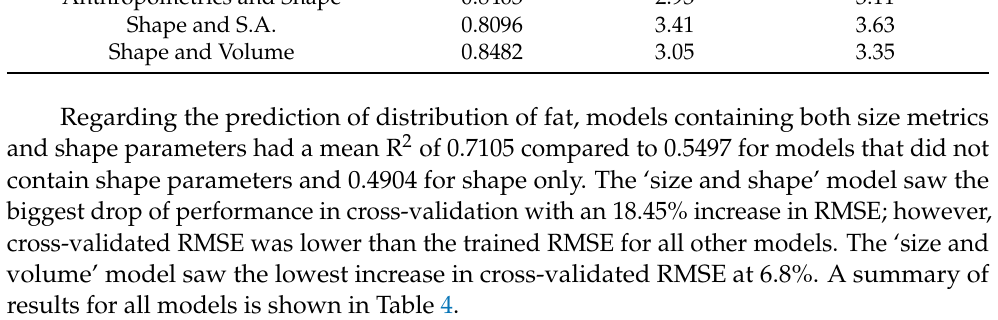
Table 4. Performance of models predicting the distribution of body fat as a ratio. Model Adj. R 2 RMSE Cross-Val RMSE Shape only 0.4904 Anthropometrics and S.A.